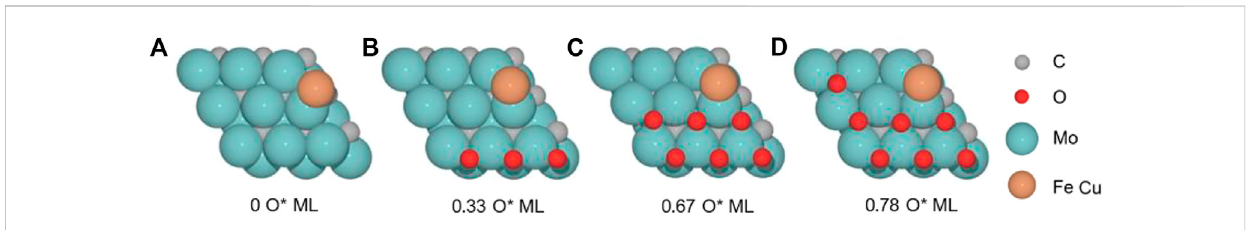
FIGURE 2 Top and side views of the structure of M/Mo 2 C catalyst (M = Cu and Fe) with (A) 0 ML, (B) 0.33 ML, (C) 0.67 ML, and (D) 0.78 ML surface oxygen coverages. Gray, cyan, red, and bronze spheres indicate carbon (C), molybdenum (Mo), oxygen (O), and metal (Cu and Fe) atoms, respectively.